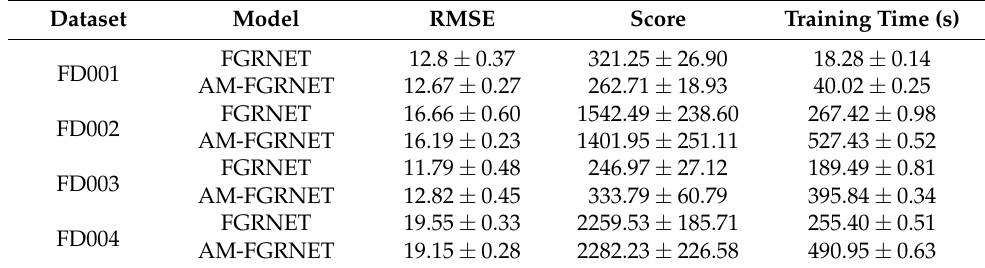
Table 11. Comparison between FGRNET and